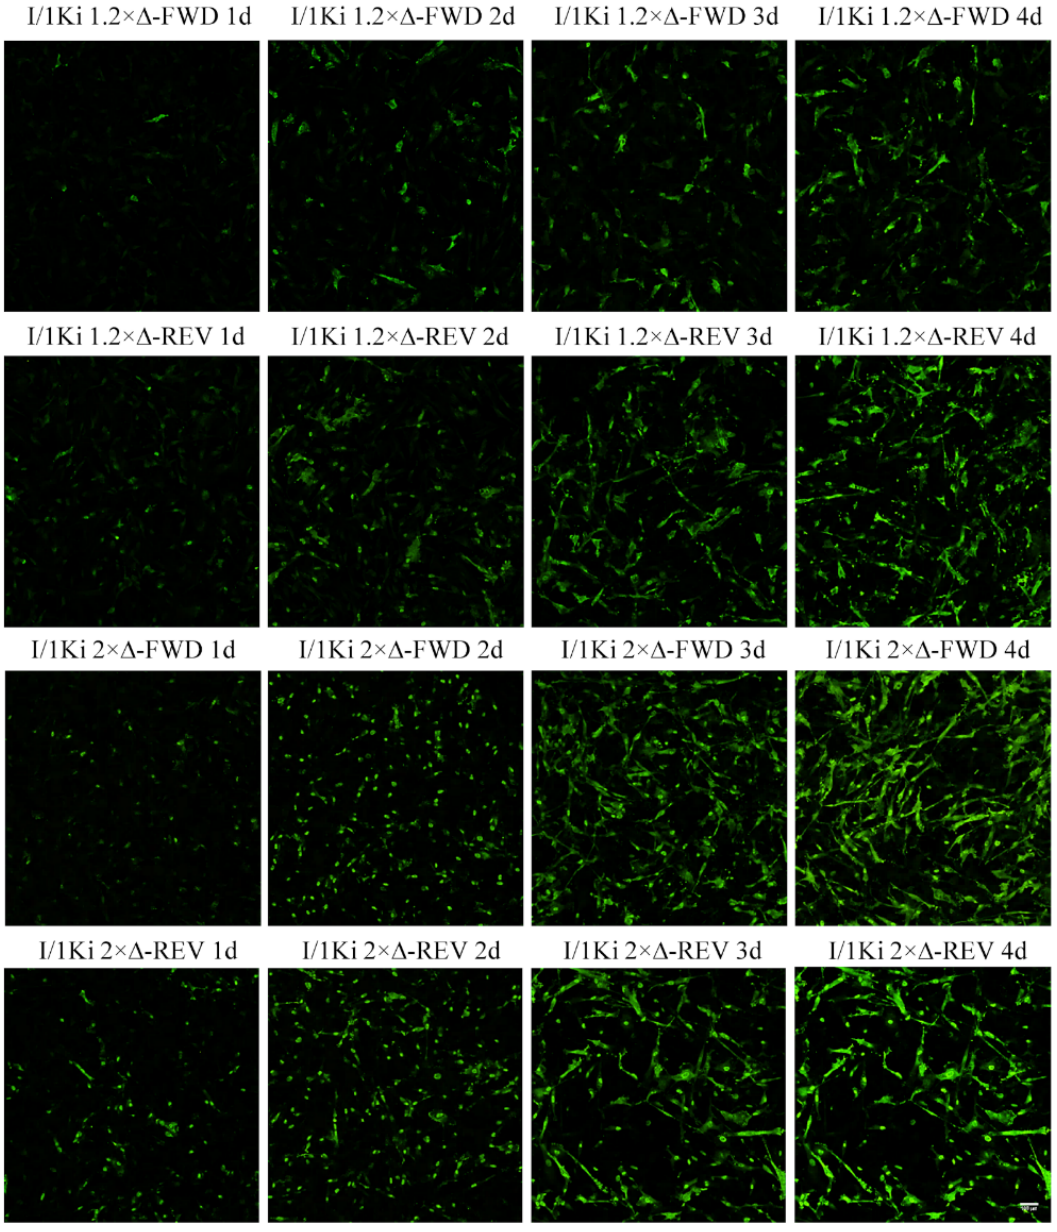
Figure 3. Expression of DAg in I/1Ki cells following transfection with 2× and 1.2× genome SwSCV- 1 FWD and REV plasmids. I/1Ki cells transfected with 2× and 1.2× SwSCV-1 FWD and REV plasmids were fixed and stained for the DAg using rabbit α -SwSCV-1 DAg antiserum at 1–4 days post transfection. AlexaFluor 488-labeled donkey anti-rabbit IgG served as the secondary antibody for DAg detection. The images were captured using Opera Phenix High Content Screening System (PerkinElmer) with 20× objective.